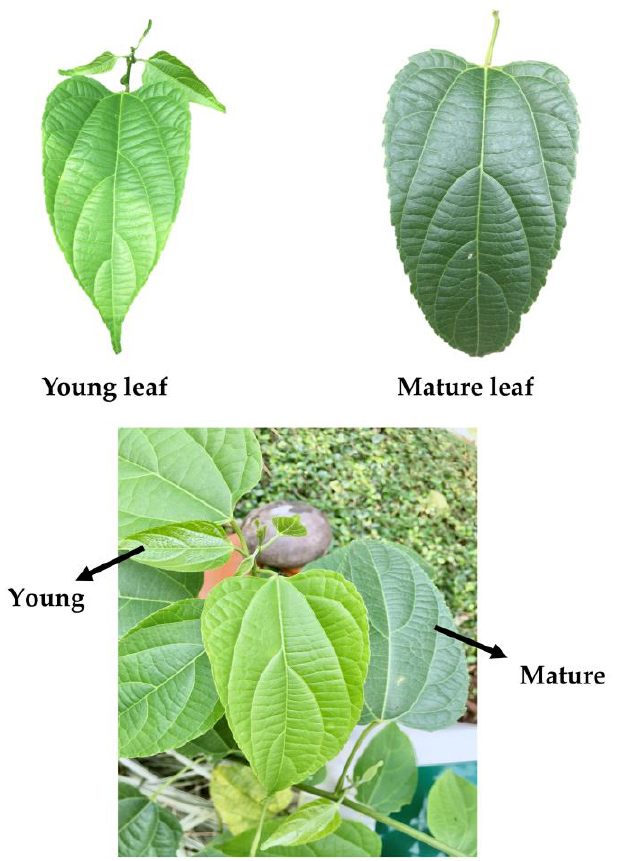
Figure 1. The physical appearances of young and mature leaves of sacha inchi.